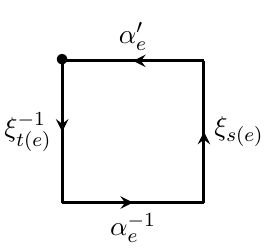
Figure 20 . Extension problem encountered in the construction of a homotopy between two maps X → BG cell by cell. The bold dot is the chosen base point of the